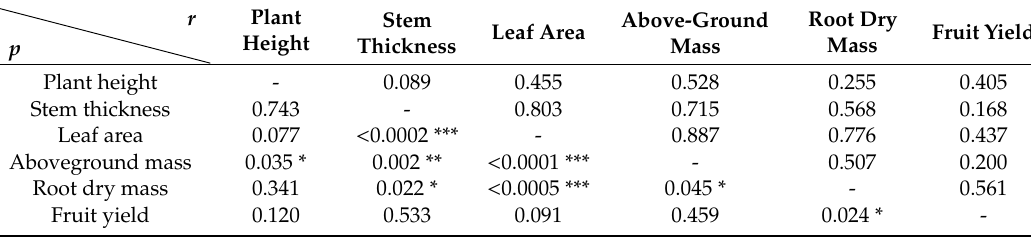
Table 3. Pearson correlation analysis ( r ) and p -value ( p ) between the investigated plant parameters for the different treatments at the end of the experiment (W12). * Correlation is significant at the 0.05 level, ** correlation is significant at the 0.01 level, and *** correlation is significant at the 0.001 level.